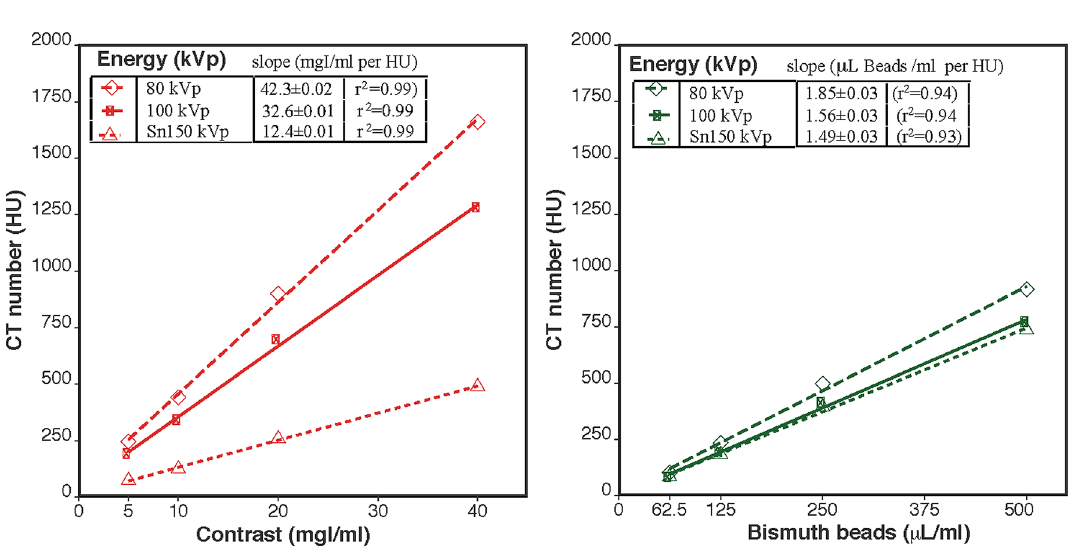
Figure 5. Clinical dual energy CT imaging. Linear regression between the image intensity or CT number (HU) for each of three energy levels and agarose gel content, either iodine (left) or bismuth beads 6